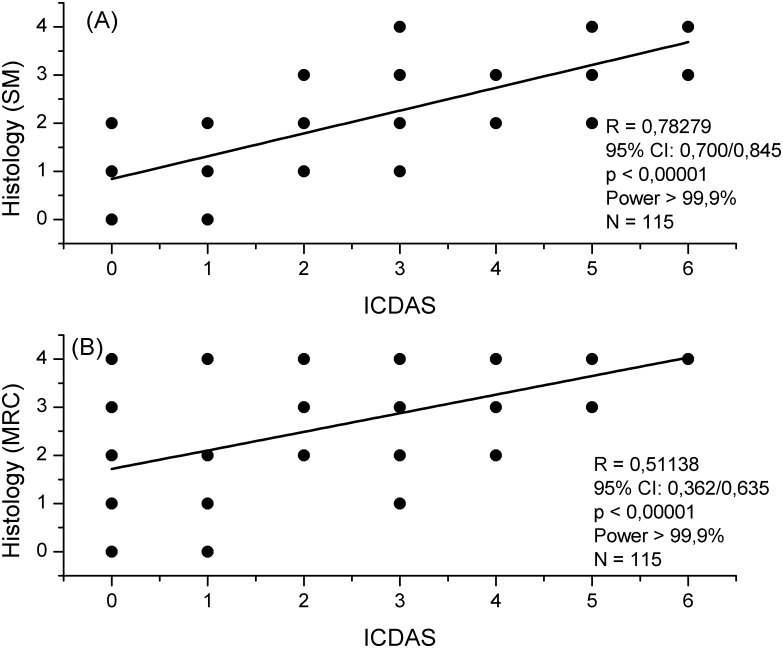
Correlation between ICDAS and histology (SM and MRC).Plots of ICDAS scores against the histological scores measured by SM (A) and MRC (B), along with corresponding correlation coefficients, 95% confidence intervals, statistical significance, and power. Most data points are overlapped; this is why there are a few filled circles.